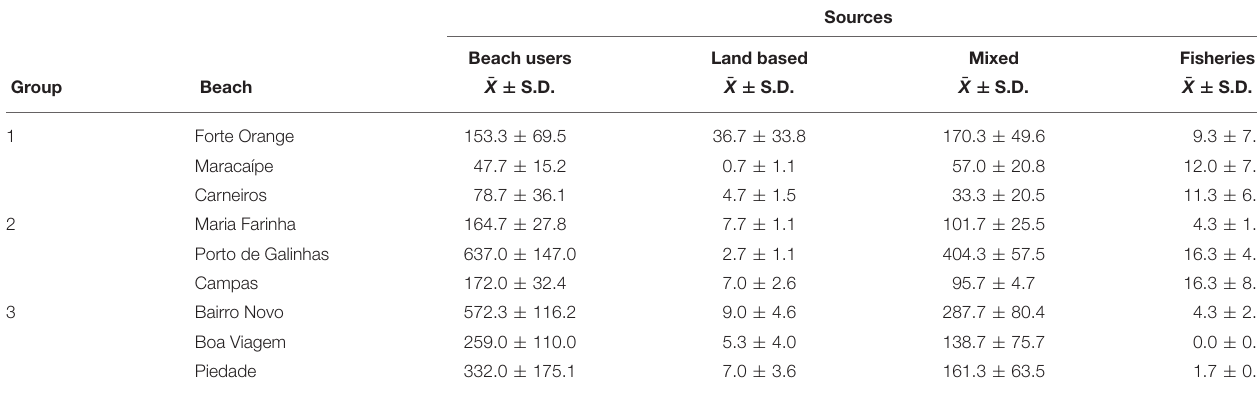
TABLE 3 | Mean value of items according to their possible source for all evaluated beaches.